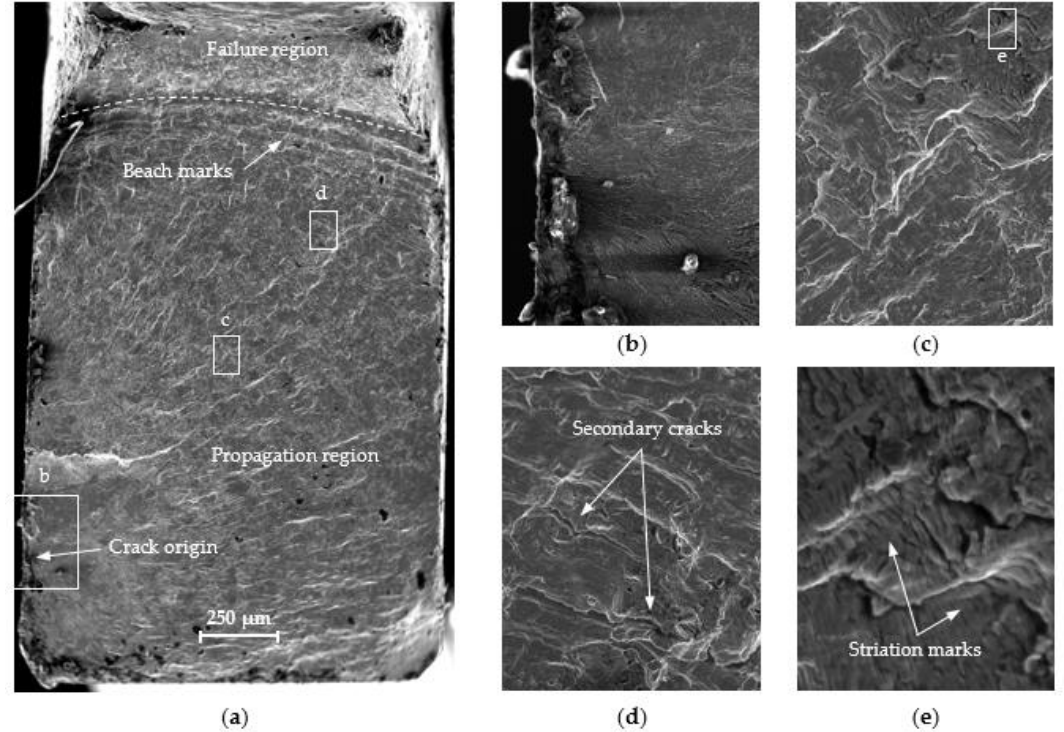
Figure 11. Fracture surfaces of mini-specimen made of 1.4301 steel: ( a ) overall surface; ( b ) crack origin; ( c ) propagation region; ( d ) secondary cracks; ( e ) striation marks.